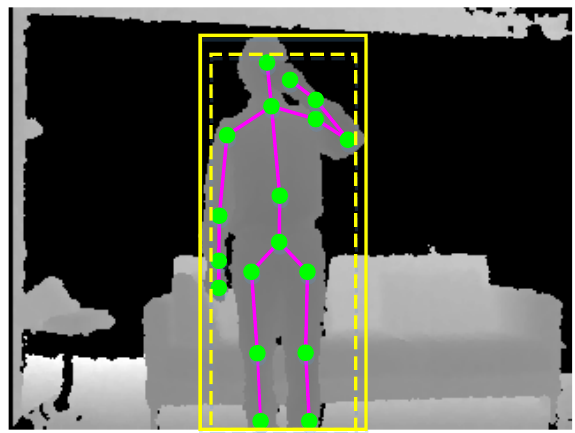
Figure 5. Human foreground extraction from a depth map using the rectangular envelope of the skeleton.